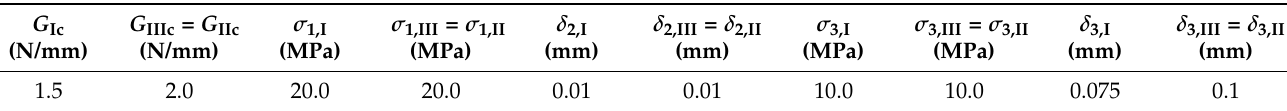
Table 3. Parameters of the cohesive mixed-mode (I+II) law for the goat cortical bone obtained by the inverse procedure detailed in